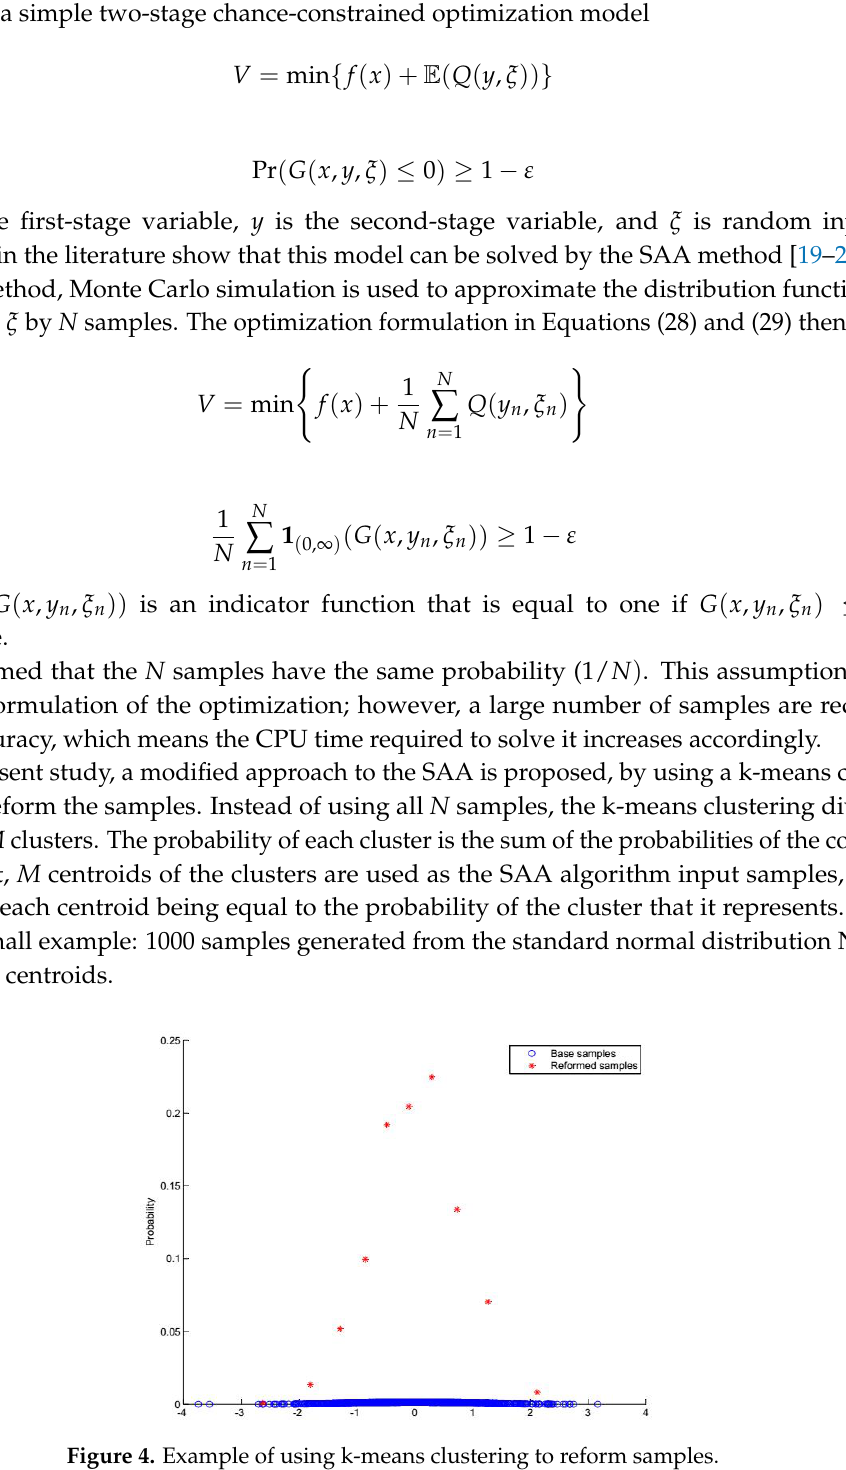
Figure 4. Example of using k-means clustering to reform samples.